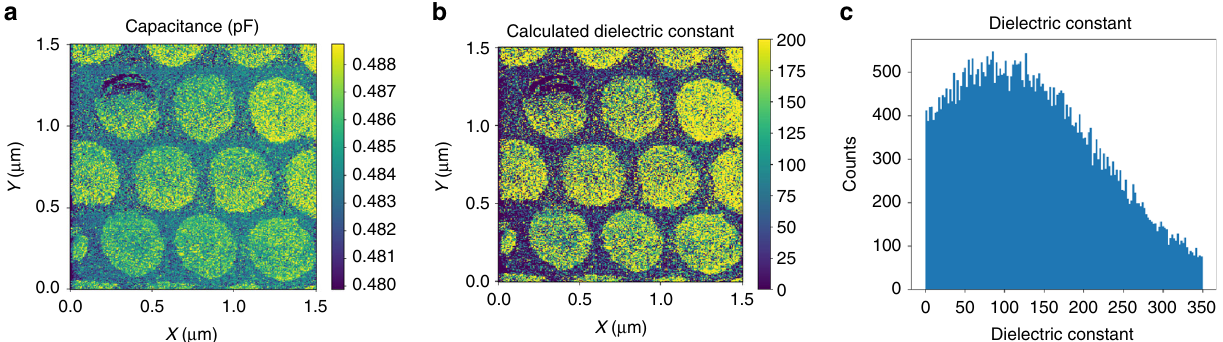
Fig. 5 Capacitance and dielectric constant determination. a Spatial map of the capacitance, derived from the inference method. Subtraction of the measuring system capacitance (taken as the value of C on the bare fi lm) from the capacitance measured on each capacitor allows calculation of the dielectric constant, plotted in b , with a histogram of these results plotted in c . The histogram peaks at ~100, which is reasonable for this composition of